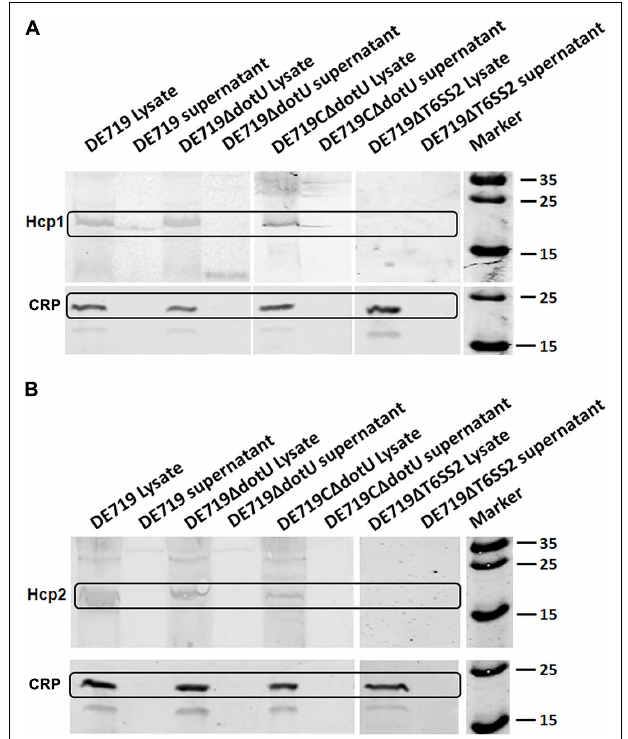
FIGURE 7 | DotU was essential for Hcp1 secretion byT6SS2 inAPEC. (A) Hcp1 secretion in APEC supernatants by western blot using anti-Hcp1. Hcp1 protein was detected at the expected size in culture supernatants of DE719 and DE719C (cid:2) dotU. No Hcp1 secretion was detected in supernatants of DE719 (cid:2) dotU and DE719 (cid:2) T6SS2. (B) No Hcp2 was detectable in supernatants of DE719 and DE719C (cid:2) dotU or lysates and supernatant of DE719 (cid:2) T6SS2. CRP was the cytoplasmic protein marker.